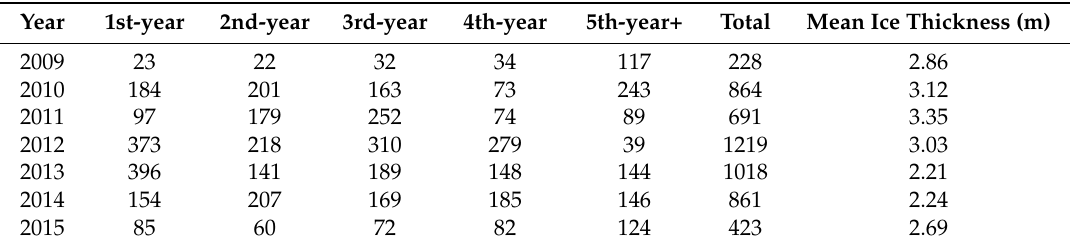
Table 1. Number of IceBridge 12.5 km ice age grid cells used for age/thickness comparison, and mean ice thickness for all sampled IceBridge